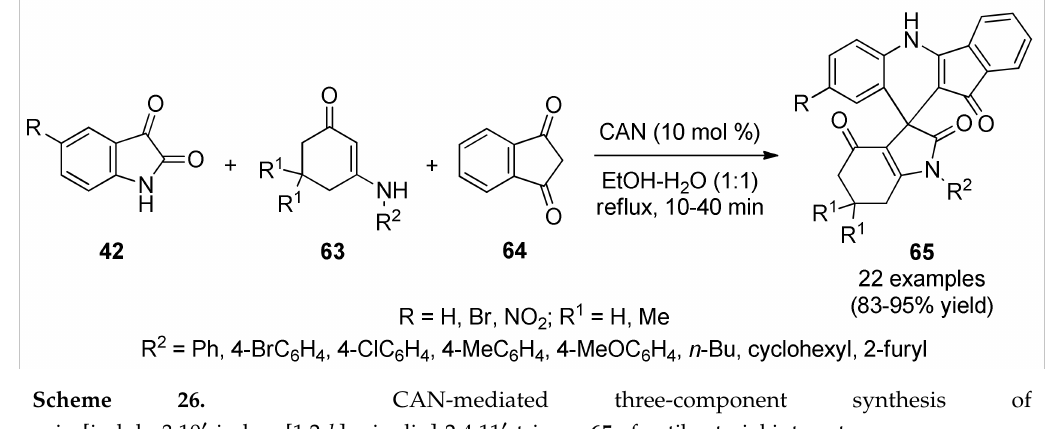
26. CAN-mediated three-component synthesis